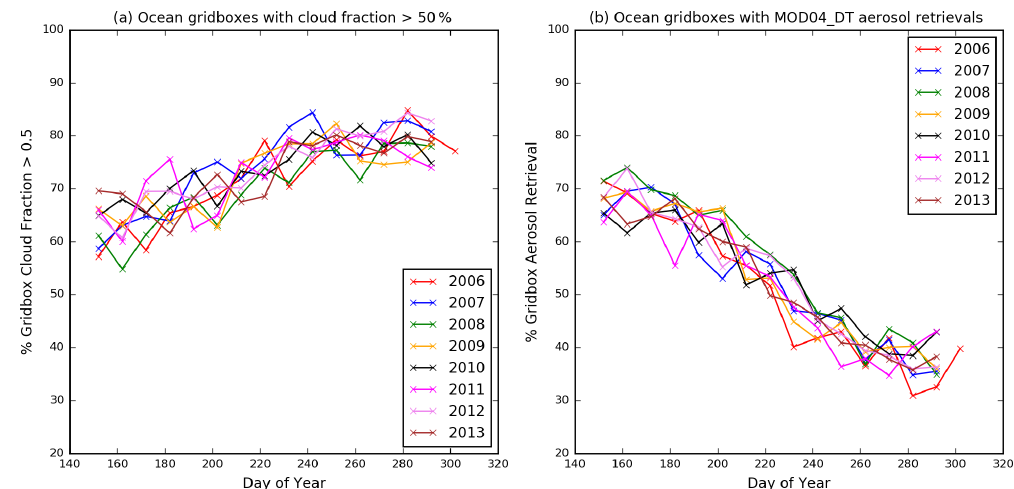
Figure 1. Terra MODIS Level-3 Daily 1-degree gridded product for SEAO area for years 2006–2013. Panel (a) shows the percentage of SEAO ocean grid boxes that had cloud fraction greater than 50%. Panel (b) shows the percentage of SEAO ocean grid boxes that had any successful MOD04DT aerosol property retrievals of any